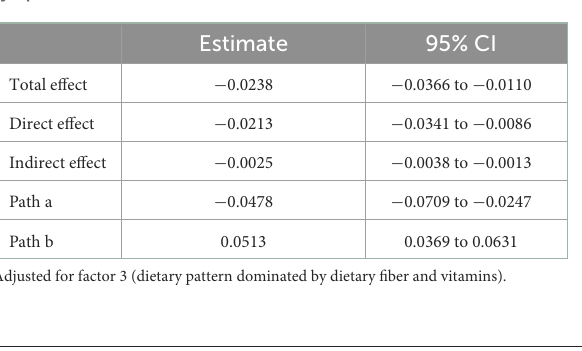
TABLE 6 Mediating analysis of dietary fiber, CRP, and depressive symptoms.